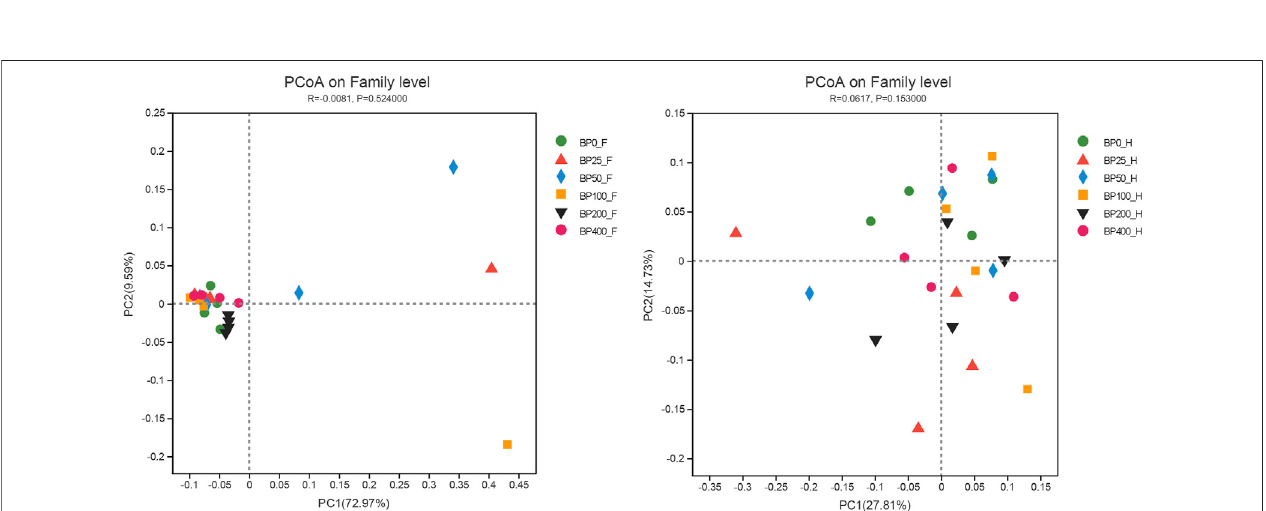
FIGURE 4 | Beta Hierarchical clustering analysis of intestinal microbiota on family level.